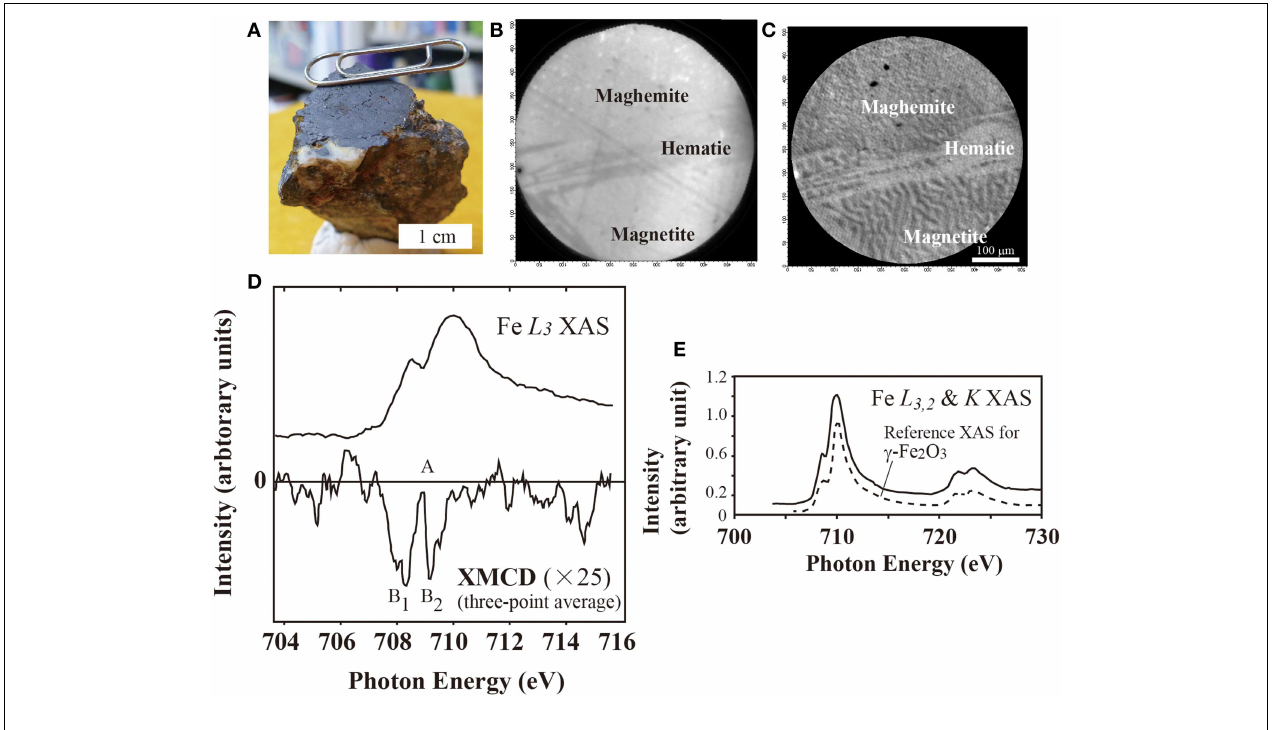
FIGURE 4 | Reference spectra of lodestone (natural permanent magnet). (A) Photograph of the sample lodestone attracting a clip. The bulk sample was obtained from the arbitrary surface shown in the photograph. The surface was polished by ¼ - µ m diamond paste and finished by colloidal silica. (B) X-ray Fe L 3 edge chemical analysis of the target area, showing oxidized magnetite (maghemite), hematite lamellae, and the host magnetite. (C) Magnetic domain structures of the corresponding area, showing the